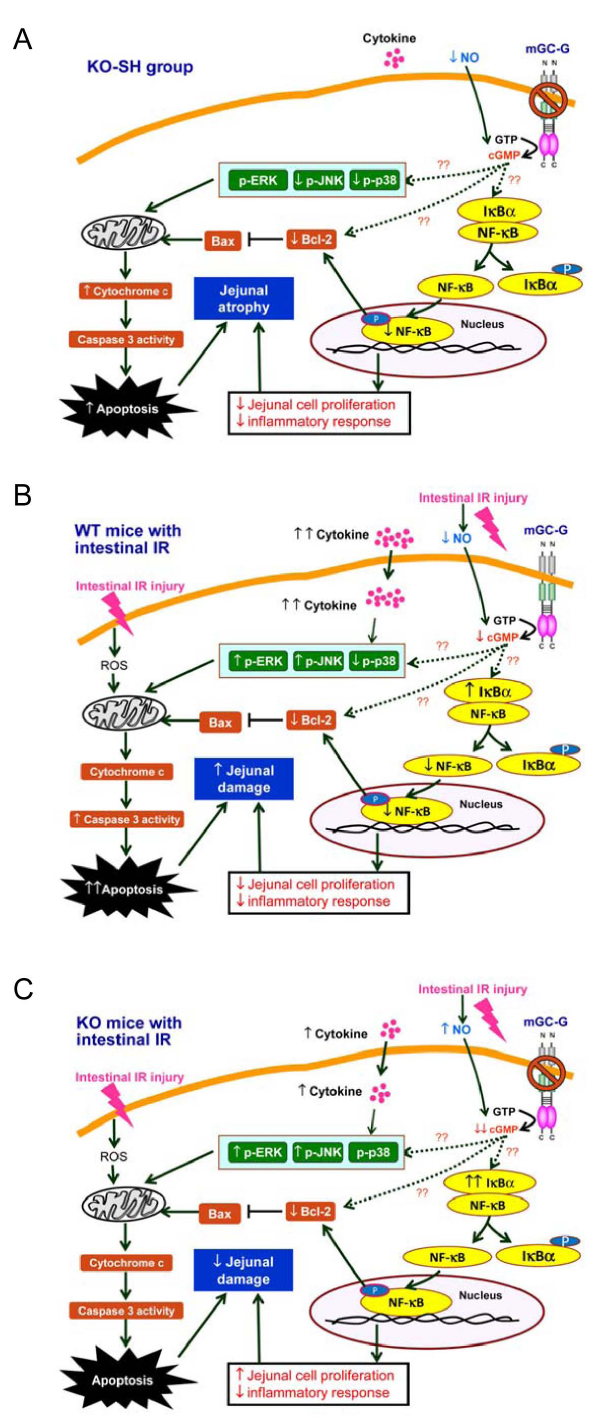
Figure 7. The hypothetical schemes of the relationships in GC- G/cGMP with major pathways contributed to jejunal atrophy in the KO-SH group (A) and to the intestinal IR-induced jejunal damage in WT (B) and KO (C) mice. The dash lines with symbols ‘‘??’’ represent unknown links between cGMP and the downstream proteins and